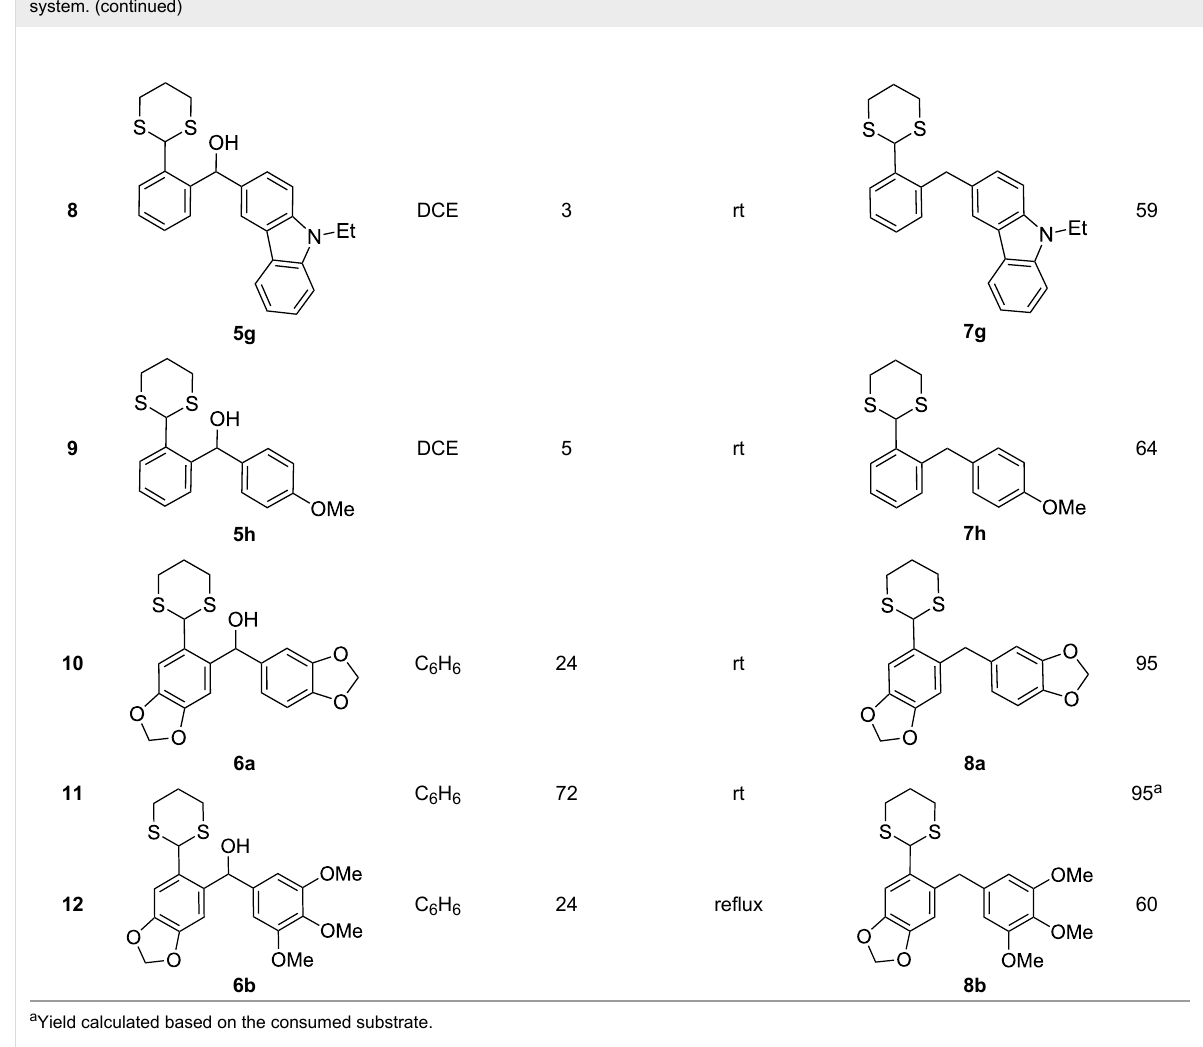
Table 1: A selective reduction of ortho- 1,3-dithianylaryl(aryl)methanols to ortho- 1,3-dithianylaryl(aryl)methanes using the ZnI 2 /Na(CN)BH 3 reducing system.